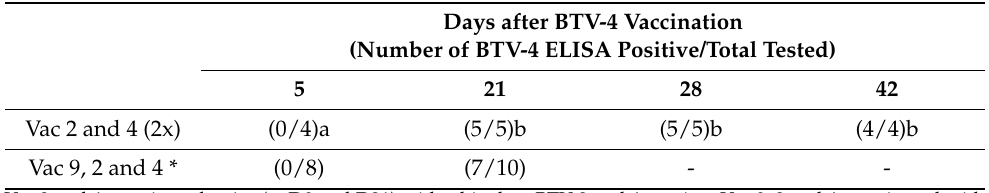
Table 3. ELISA results from sheep sera vaccinated with inactivated vaccines.